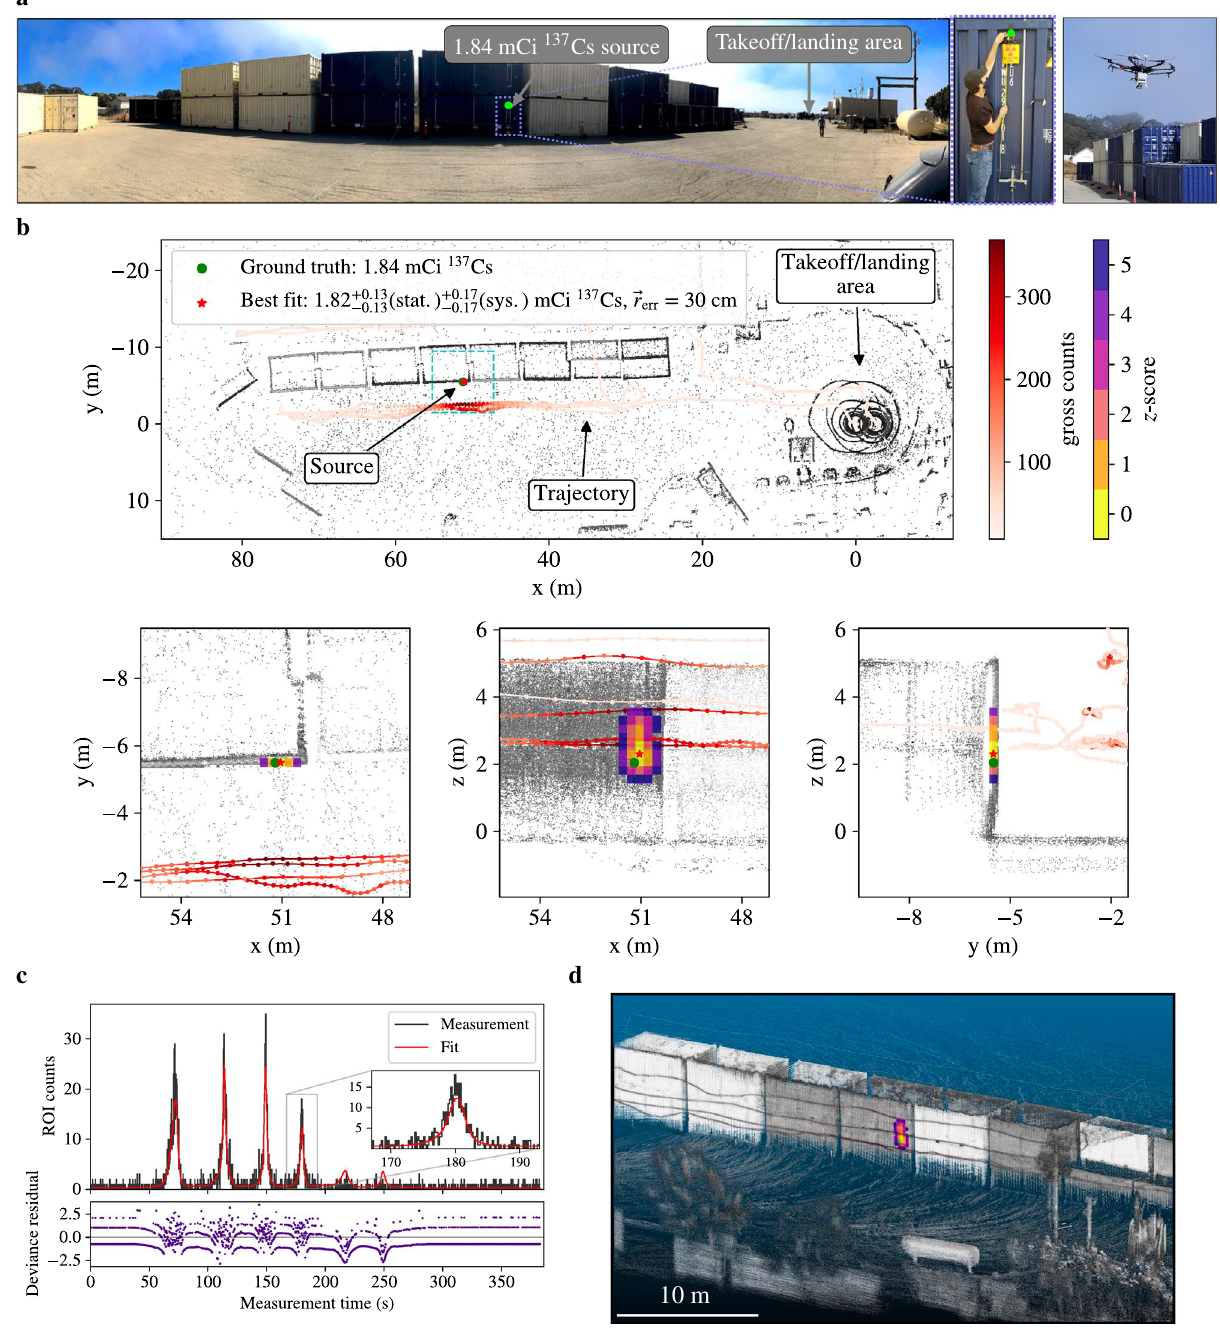
137 Cs source was